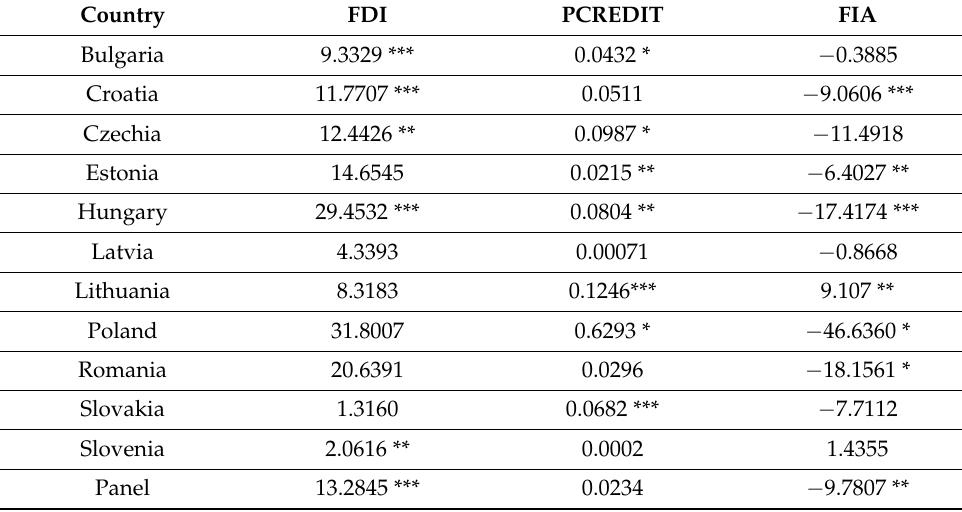
Table 7. Estimation of cointegrating coefficients.